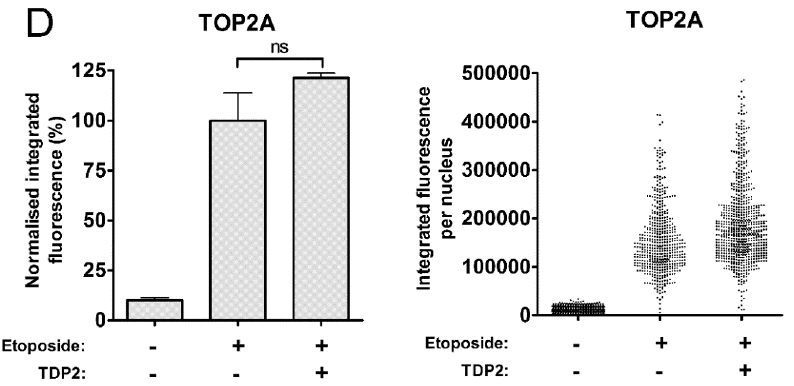
Figure 1. Effect of active TDP2 protein on the removal of topoisomerase II adducts in vitro. ( A ) Schematic of Alexa-647 labelled oligonucleotide substrate with or without tyrosine covalently attached to 5 (cid:48) -end. ( B ) Substrates were treated with 0.14, 0.7 or 1.4 µ g of TDP2 (TTRAP) protein. ( C ) Oligonucleotide substrates were treated with 1.4 µ g of TDP2 in the presence of 0, 10 or 100 mM vanadate. ( D ) Trapped in agarose DNA immunostaining (TARDIS) slides were prepared following treatment of K562 cells with 100 µ M etoposide or DMSO for 2 h. After cell lysis, slides containing agarose-embedded genomic DNA bearing TOP2 adducts were incubated for 90 min with 1 µ g active recombinant TDP2 (or TDP2 buffer). Levels of DNA-bound TOP2A and TOP2B remaining after incubation with recombinant protein were assessed by quantitative immunofluorescence (TARDIS analysis) [27]. All fluorescence values were normalised to the values obtained following exposure of cells to 100 µ M etoposide, without subsequent treatment with TDP2. Scatter diagram shows raw integrated fluorescence values from a single experiment before normalisation. Statistical comparisons were made by unpaired t -test ( n =